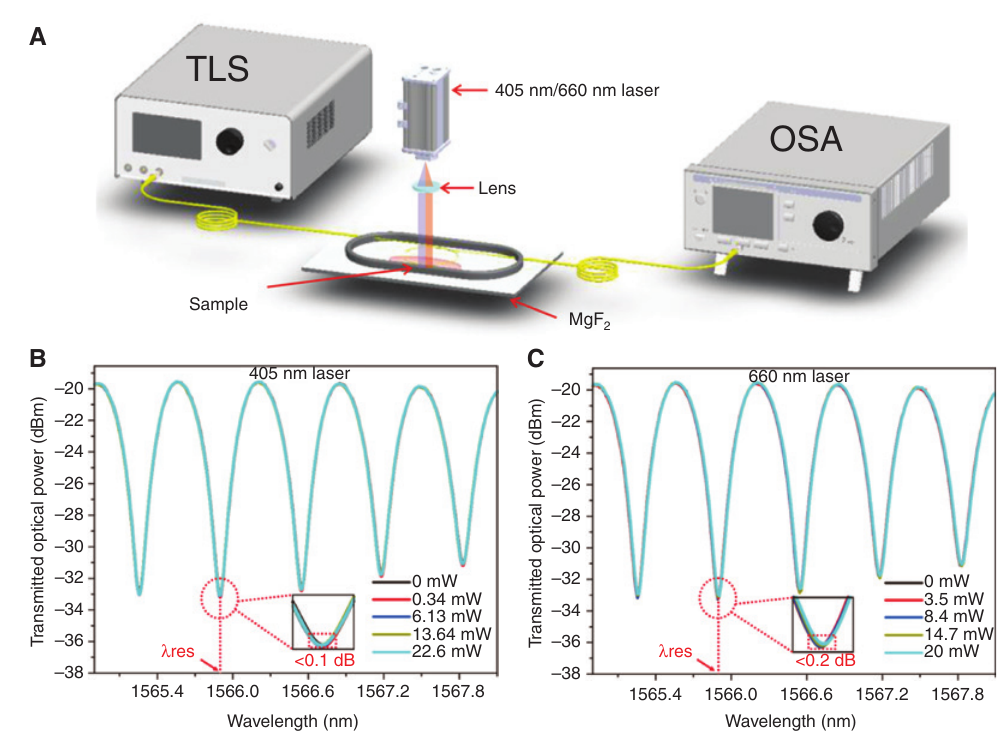
Figure 3: Results of all-otical modulation experiments on the bare MKR. (A) Experimental setup for light amplitude modulating by 405-/660-nm external pump light. Transmission spectrum of bare MKR under (B) 405-nm light illuminating with power of 0, 0.34, 6.13, 13.64, and 22.6 mW and (C) 660-nm light illuminating with power of 0, 3.5, 8.4, 14.7, and 20